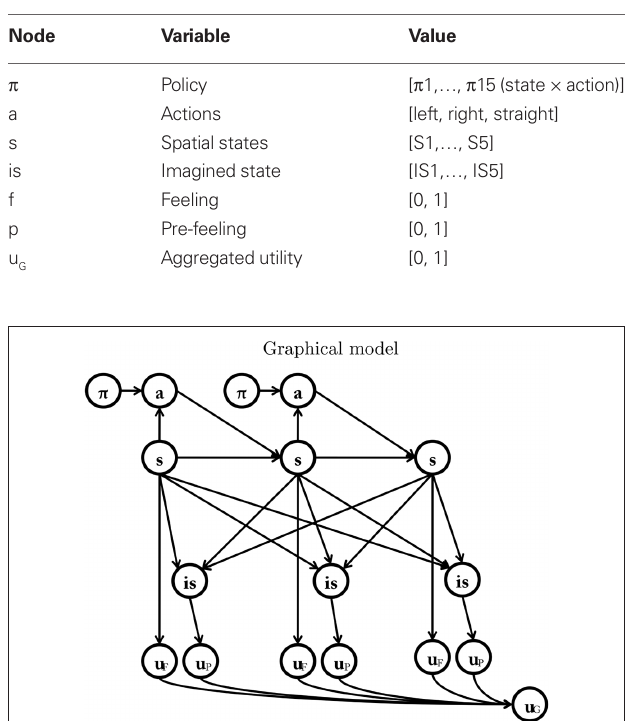
Table 4 | List of variables used in Figure 7.